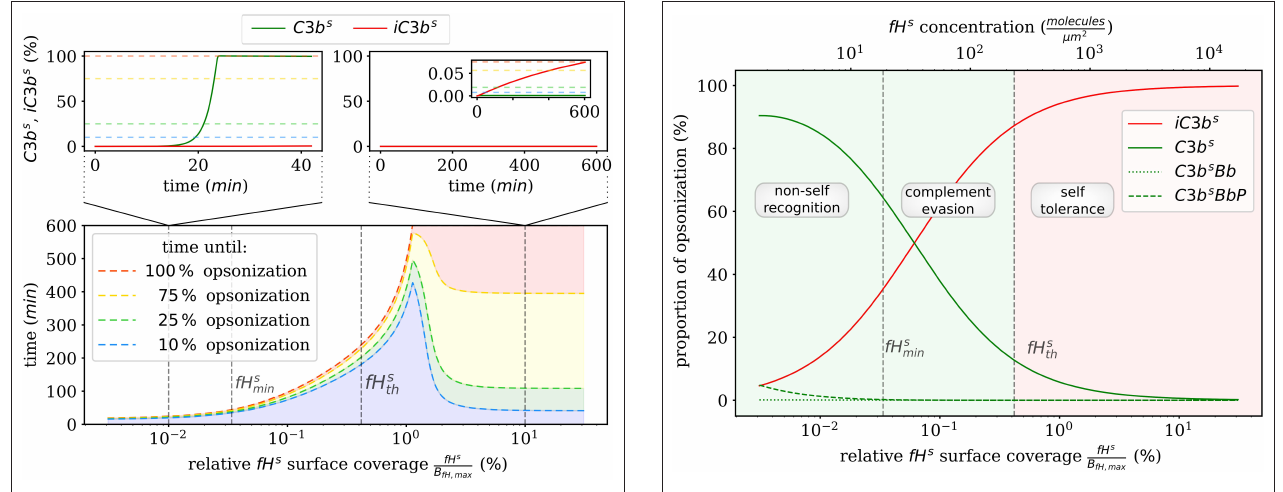
FIGURE 3 | Summary of the numerical integration of 1,000 simulations for varied fH s concentrations. The time intervals indicate how much time passes until a certain amount of C3b s is attached to the cell surface. Two typical molecular concentration dynamics are shown for small fH s concentrations (top left) and high fH s concentrations (top right).